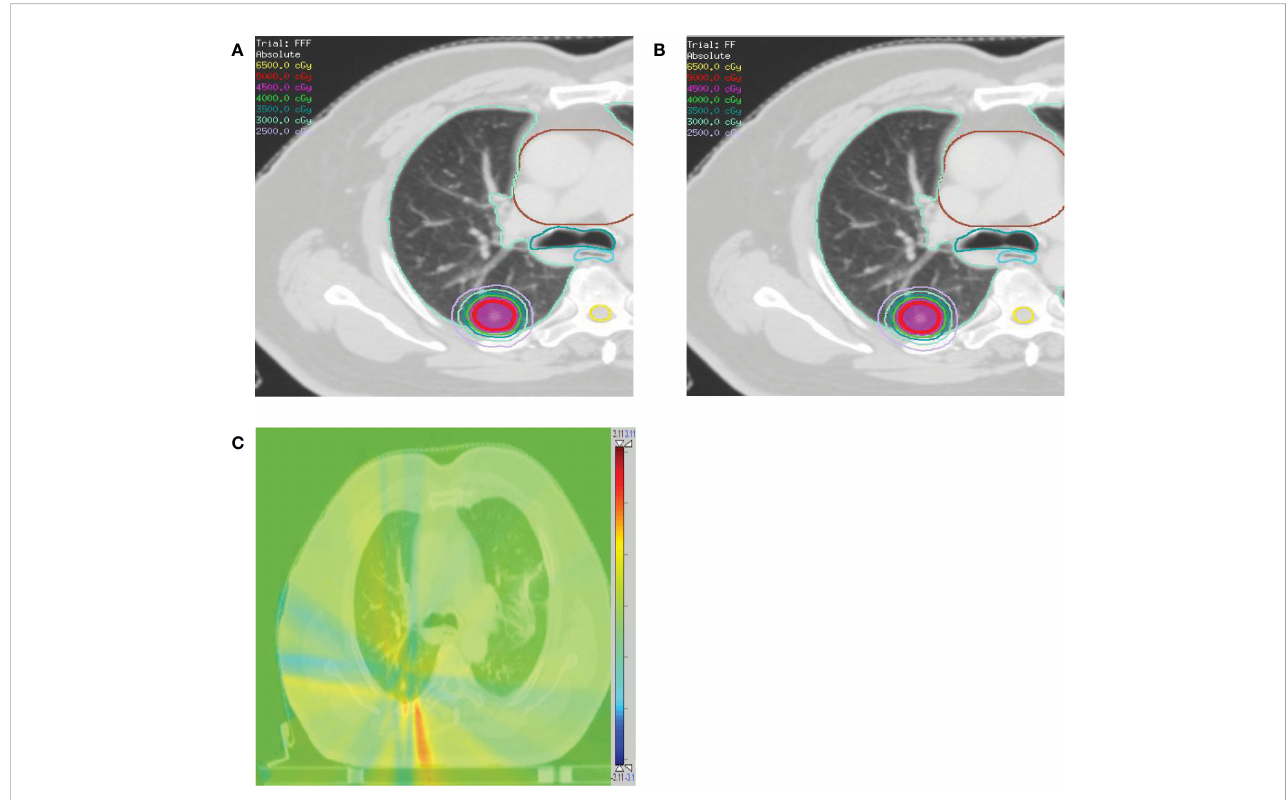
FIGURE 4 Comparison of dose distributions for a patient with contoured PTV (red), lung (light green), heart (brown), esophagus (cyan), and trachea (dark cyan). (A) VMAT FFF plan. (B) VMAT FF plan. The dose distribution ranges from 25 Gy to 65 Gy. (C) The absolute dose difference distribution between the (A) and (B) . The dose distribution ranges from -3.11 Gy (blue color) to 3.11 Gy (red